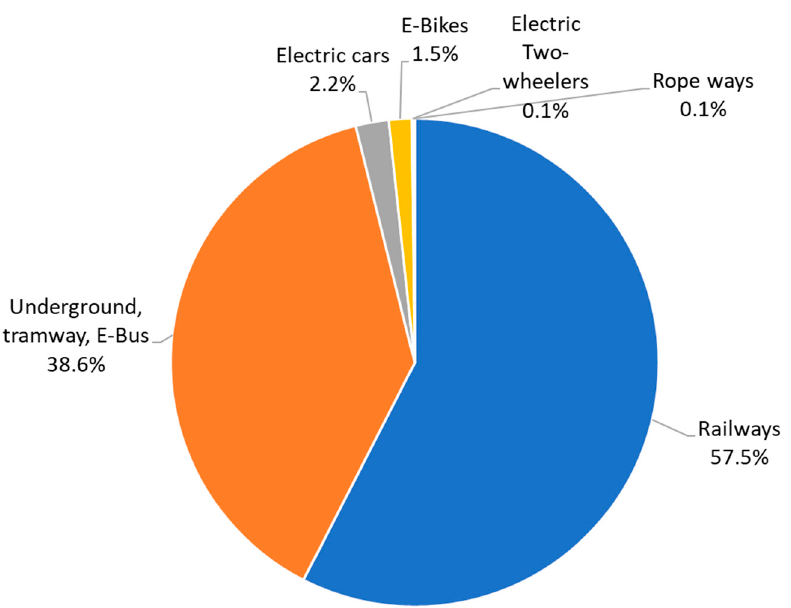
Figure 2. Shares of different modes and technologies of electric mobility by the number of kilometers driven in Austria in the year 2018 (Data source: [2]).